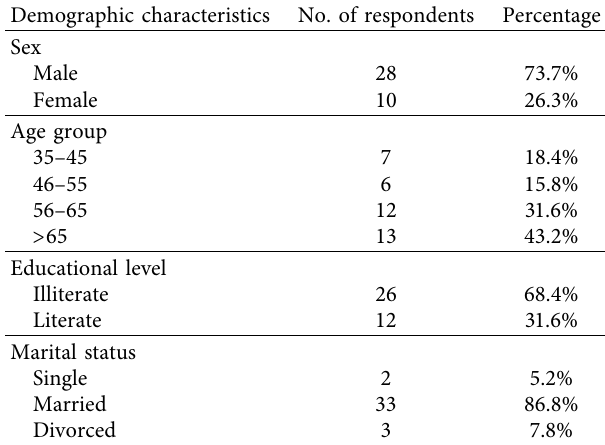
Figure 2: Group discussion with the respondents of the study at Gumba kebele, Assosa District. Table 1: Sociodemographic profile of the respondents included in the survey ( n �